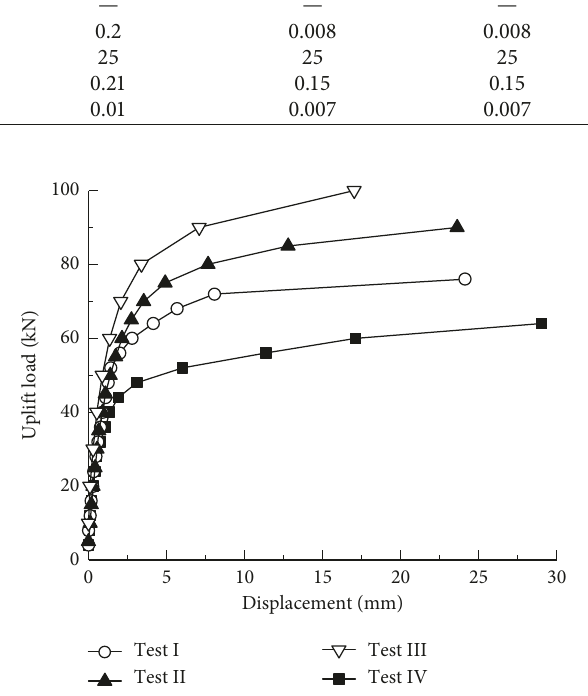
Figure 18: Load-displacement curves of belled pier